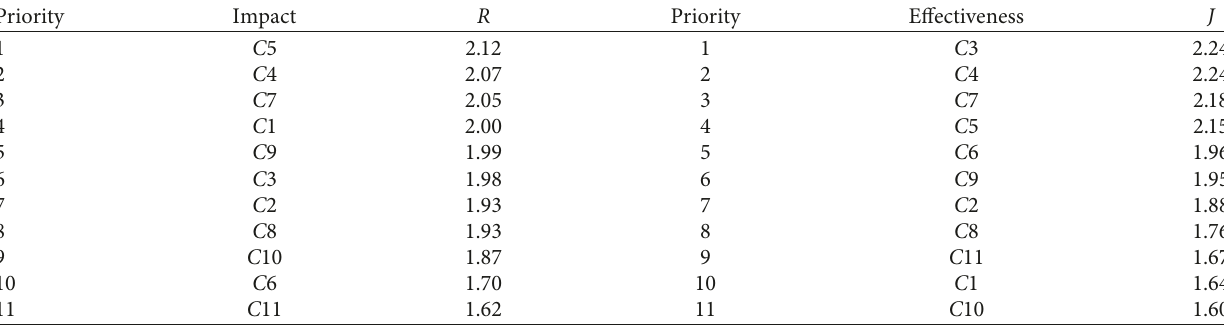
Table 7: The order of impact and effectiveness of subcriteria in relation to each other.